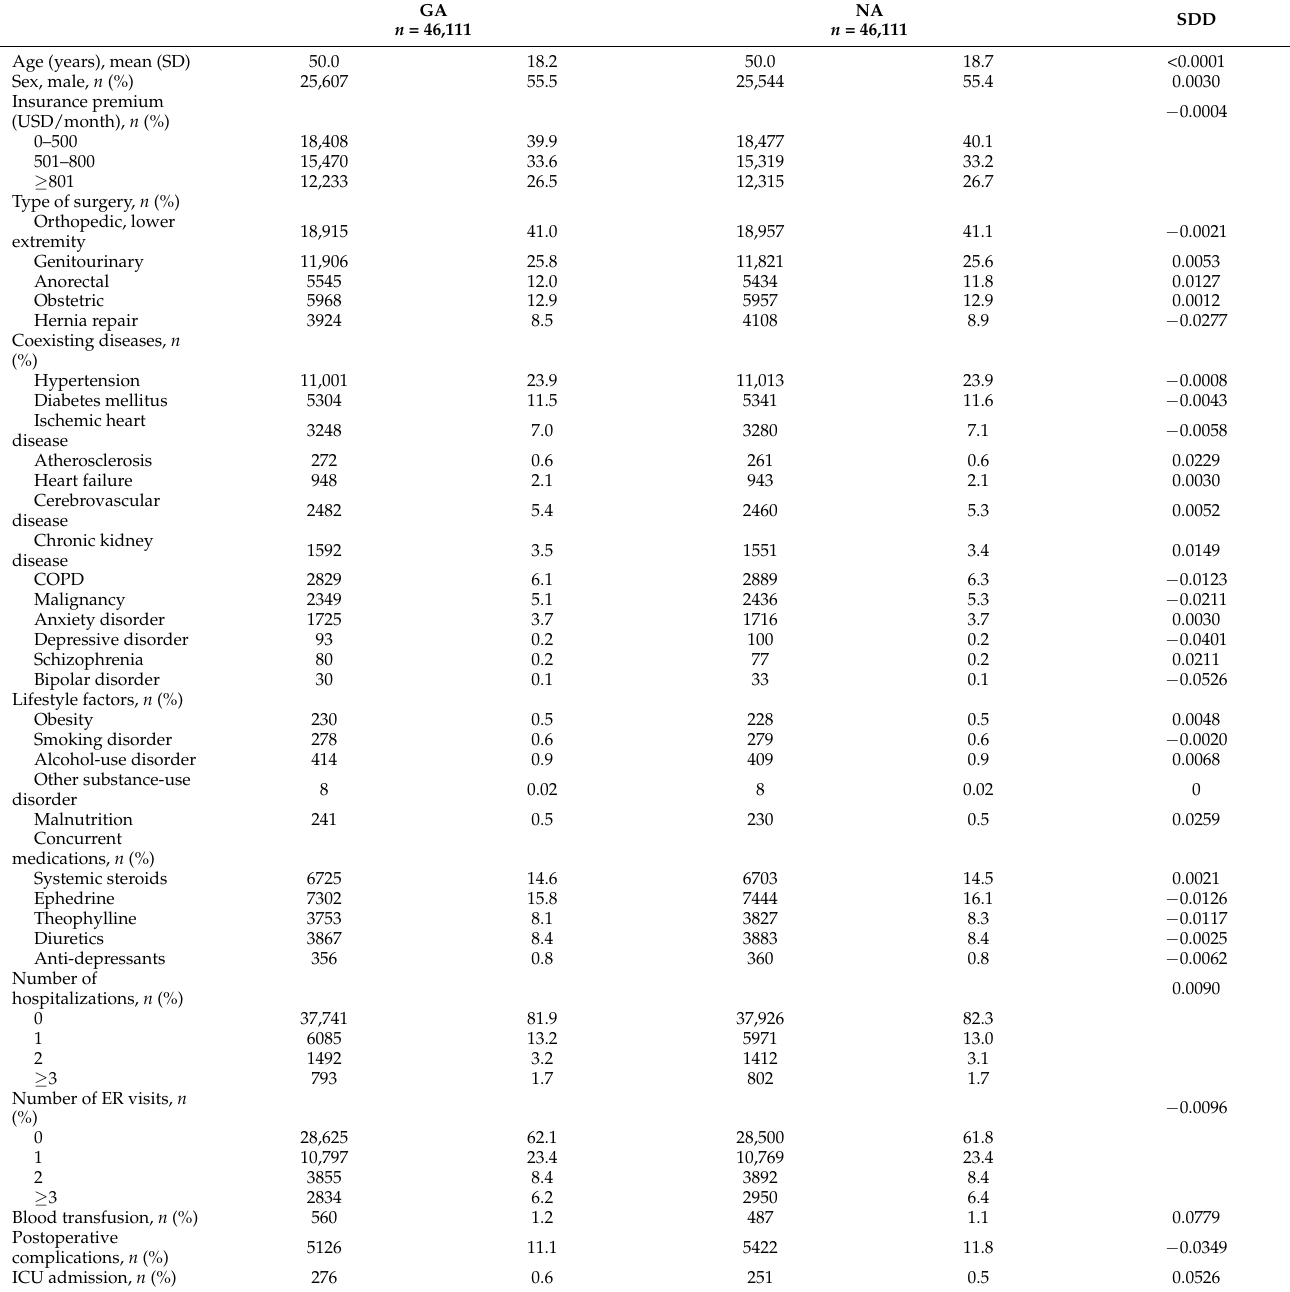
Table 1. Baseline characteristics of patients undergoing general and neuraxial